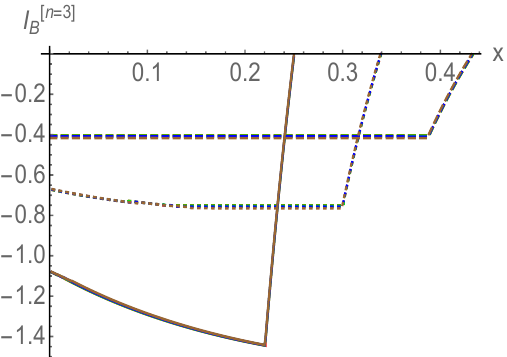
Figure 33 . Tri-partite information I [ n =3] a function of ‘ for various values of chemical potential in the specious con(cid:12)ned phase. Here T = 0 : 9 T c and solid, dotted and dashed lines correspond to x =0 : 1, 0 : 15 and 0 : 2 respectively. The red, green, blue and brown curves corre- spond to (cid:22) = 0, 0 : 1, 0 : 2 and 0 : 3 respectively. In units GeV.